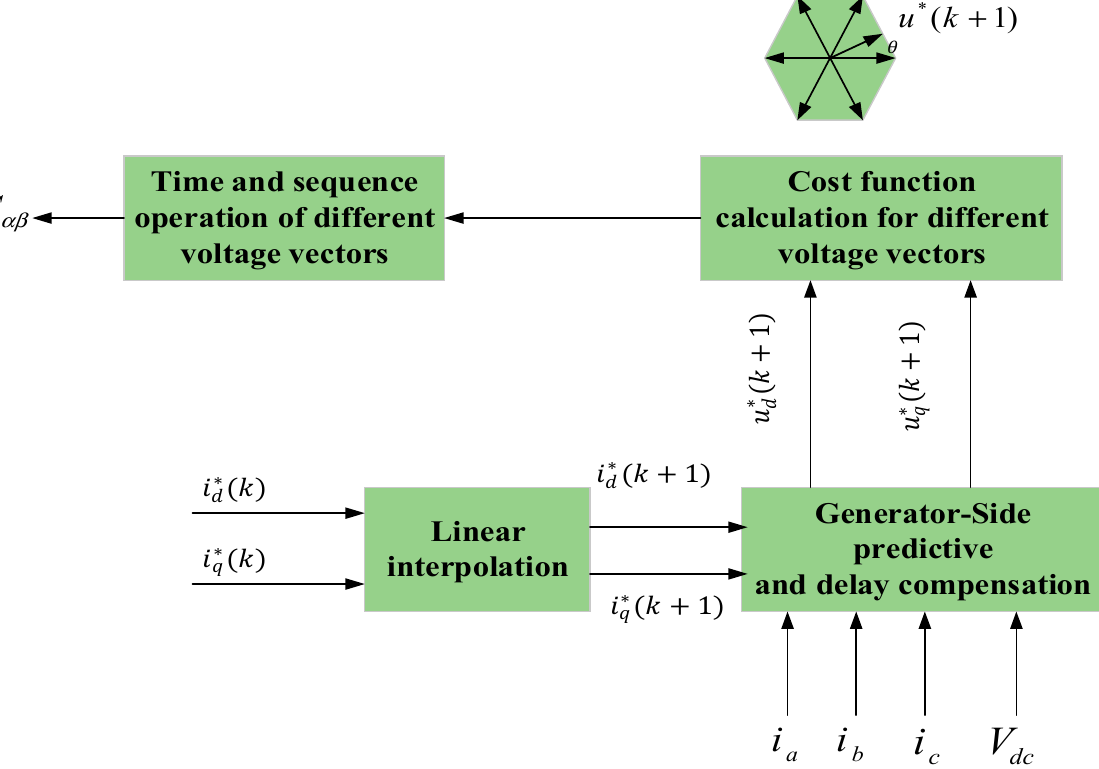
Figure 6. Proposed taxonomy of modulated model predictive control for the MSC. From the previously written equations, the predicted voltage vectors in discrete-time form which is used to obtain the future values of the output variables on one sampling time 𝑇 (cid:3046) can be written based on normal forward Euler approximation [11,34]